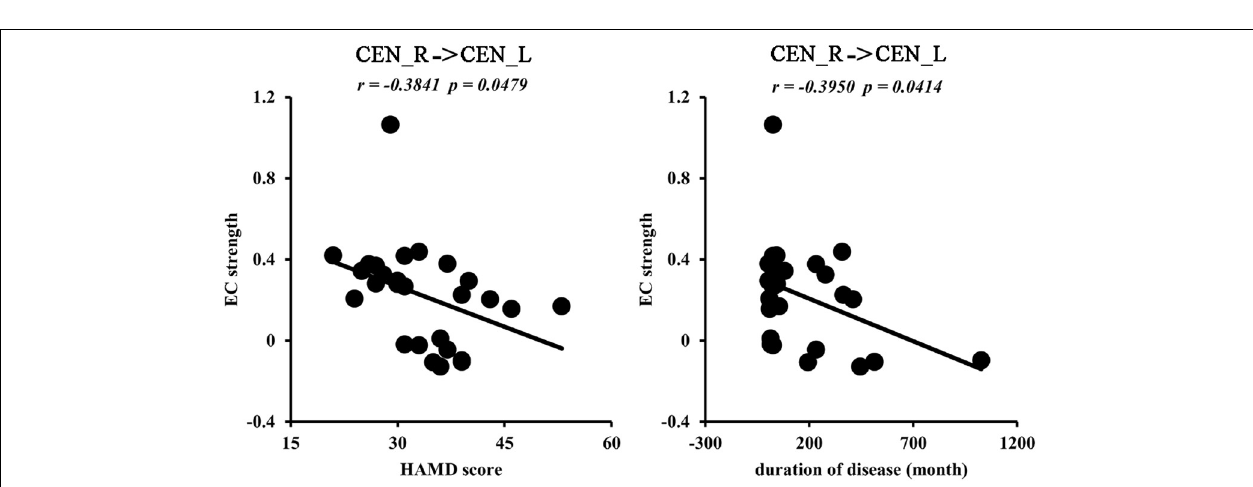
FIGURE 4 | The differences in dynamic functional connectivity (dFC). The significantly decreased dFC between right central executive network (CEN) and salience network (SAL), default mode network (DMN) was found in MDD patients compared to healthy controls. *Represents significant difference.